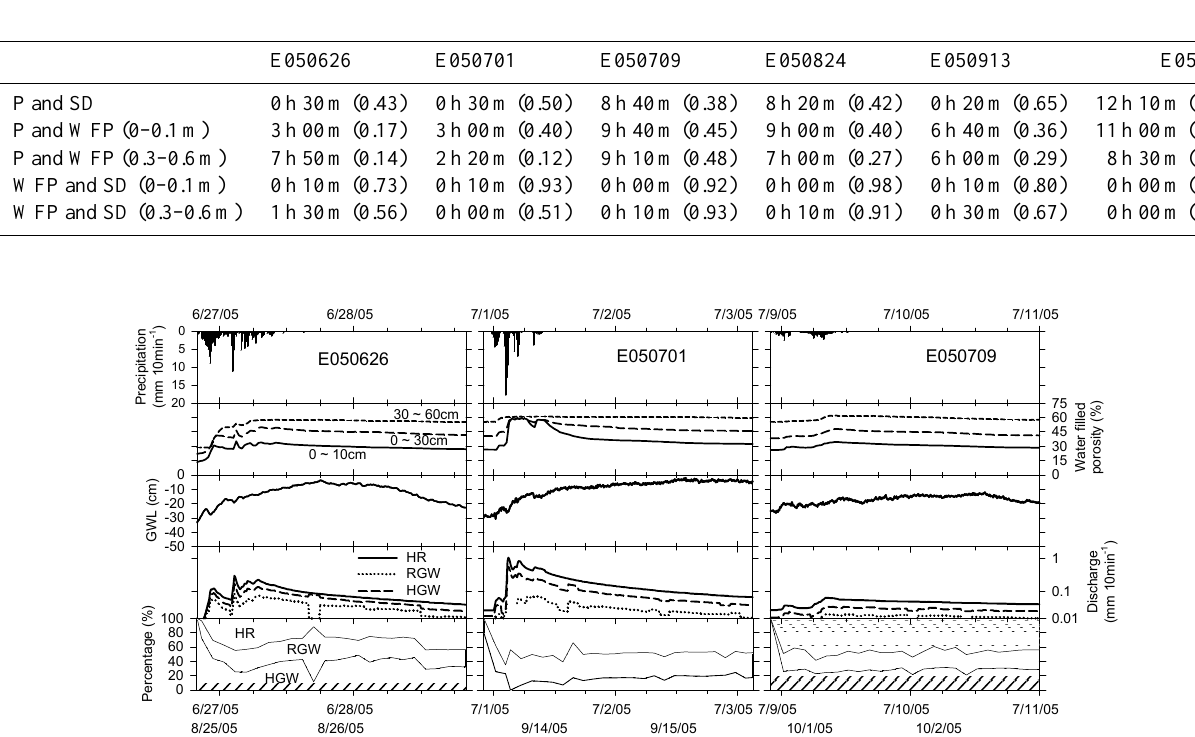
Table 4. Estimated time lags among Stream Discharge (SD), Precipitation (P), and Water-Filled Porosity (WFP). The numbers in the parentheses indicate cross correlation coefficients ( p< 0.01).